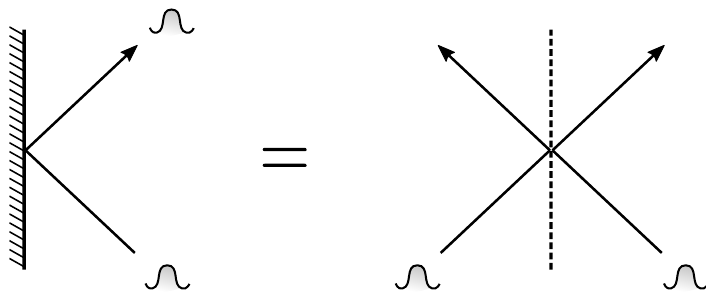
Figure 34 . The method of images for computing the time-delay at strong